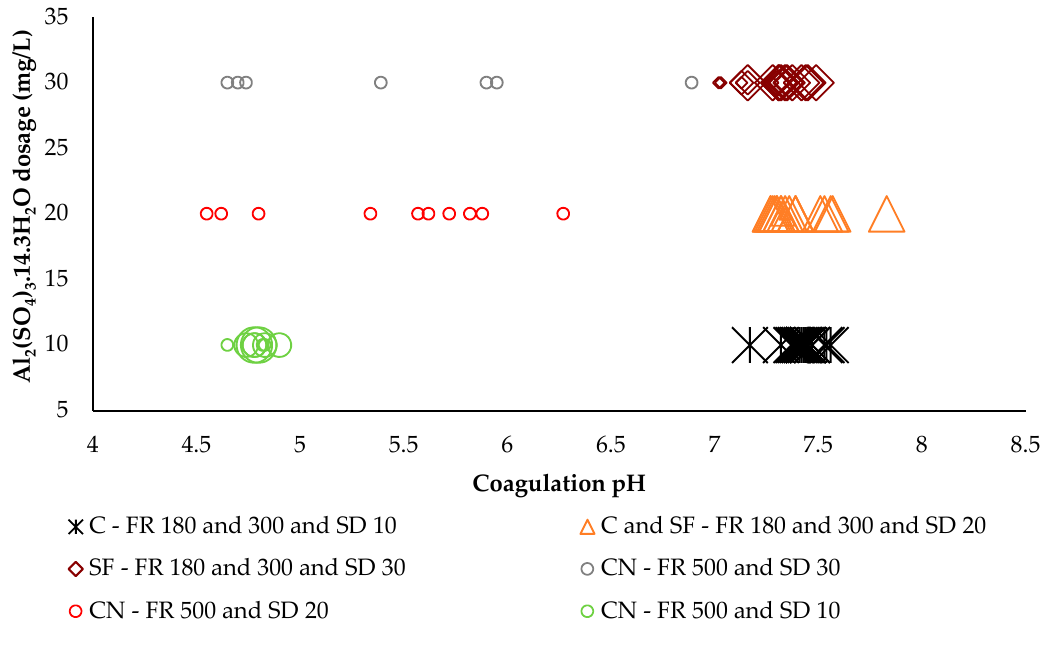
Figure 9. Coagulation diagram with remaining color points in relation to coagulation pH and aluminium sulfate dosage—pilot Water Treatment Plant. Smaller symbols: remaining color > 15 uH, intermediate size symbols: remaining color between 5 uH and 15 uH, and larger symbols: remaining color < 5 uH.